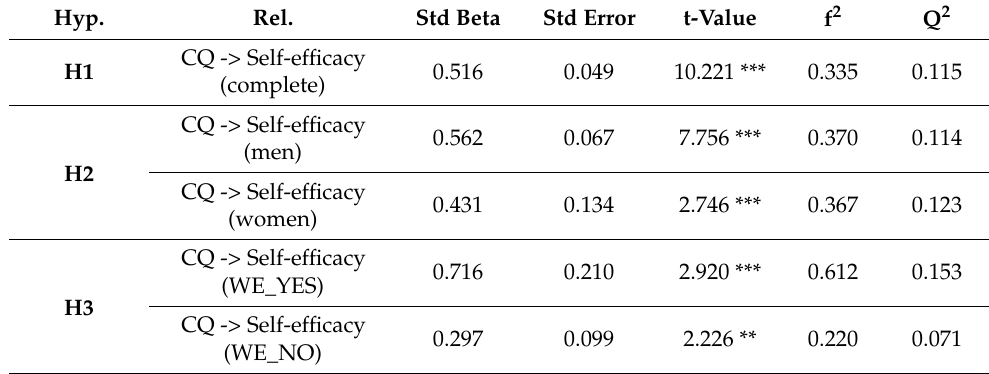
Table 4. Direct Relationships for Hypothesis testing and Multigroup analysis (MGA-PLS). Hyp. Rel. Std